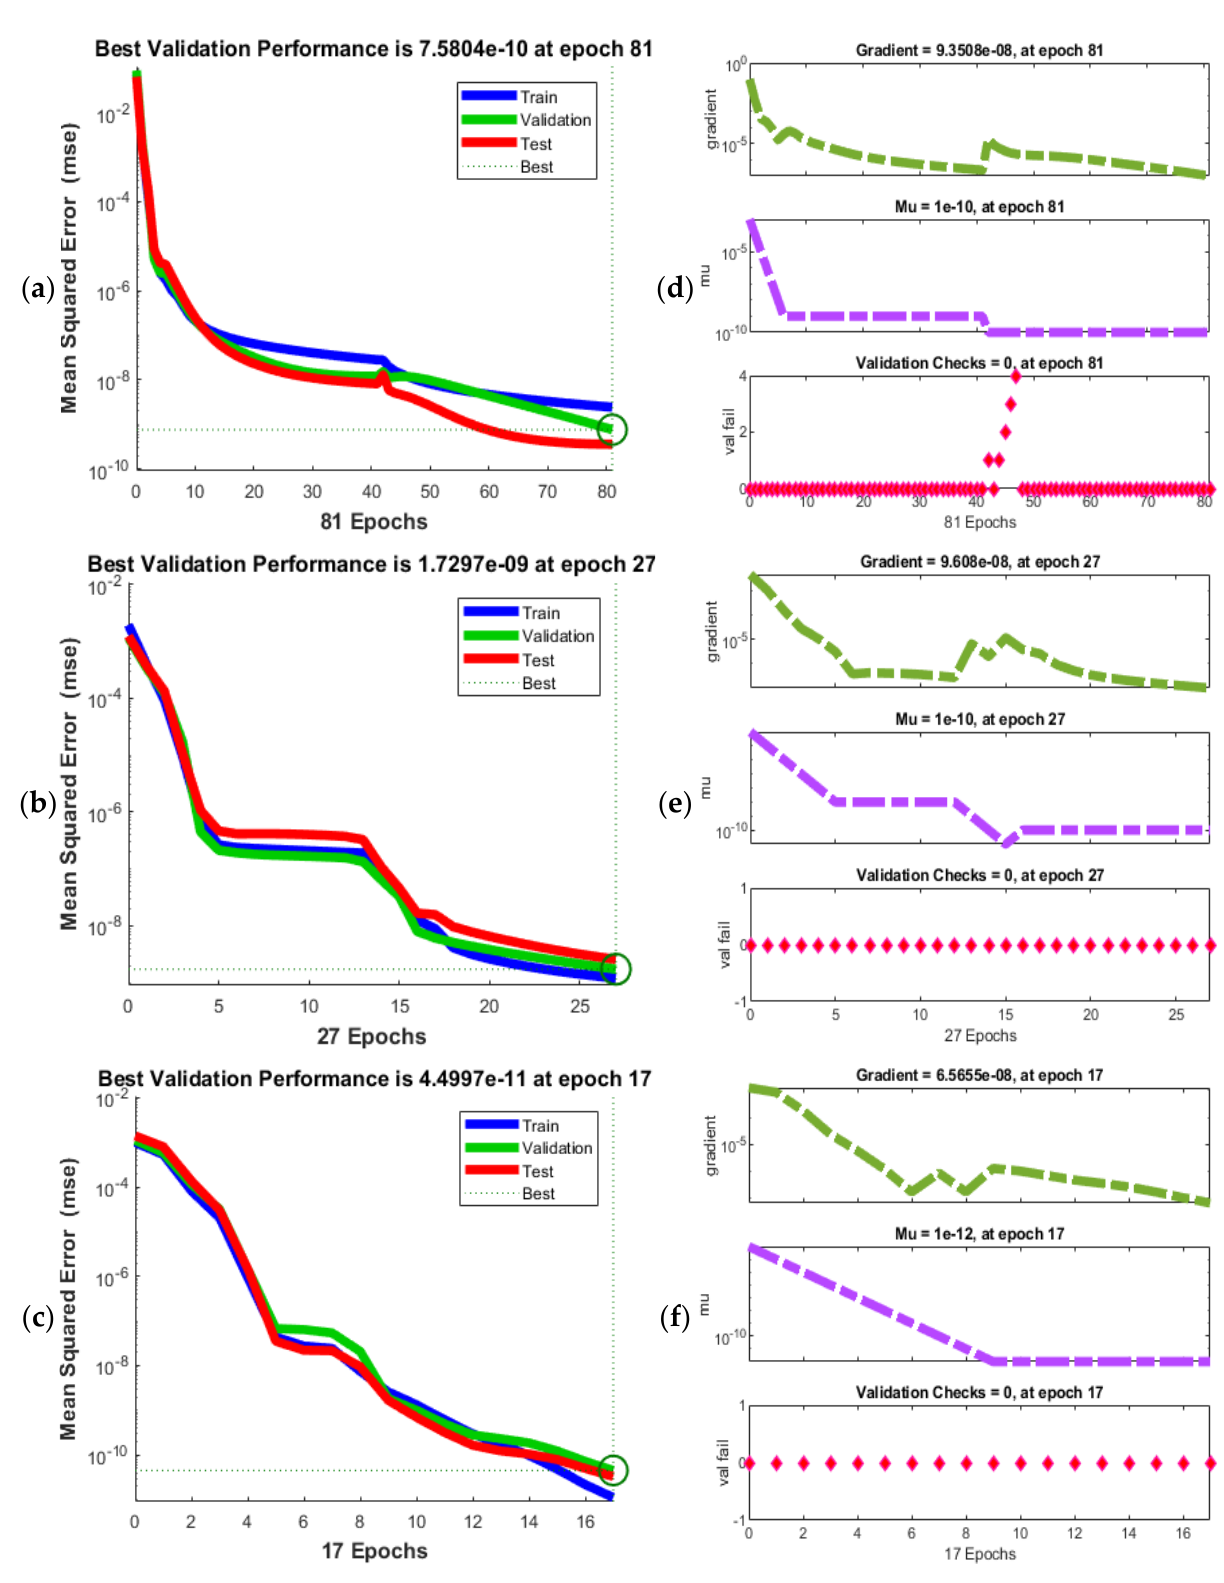
Figure 3. MSE and STs for the mathematical form of the FKFS model. ( a ) MSE for C-1; ( b ) MSE for C-2; ( c ) MSE for C-3; ( d ) EHs for C-1; ( e ) EHs for C-2; ( f ) EHs for C-3.